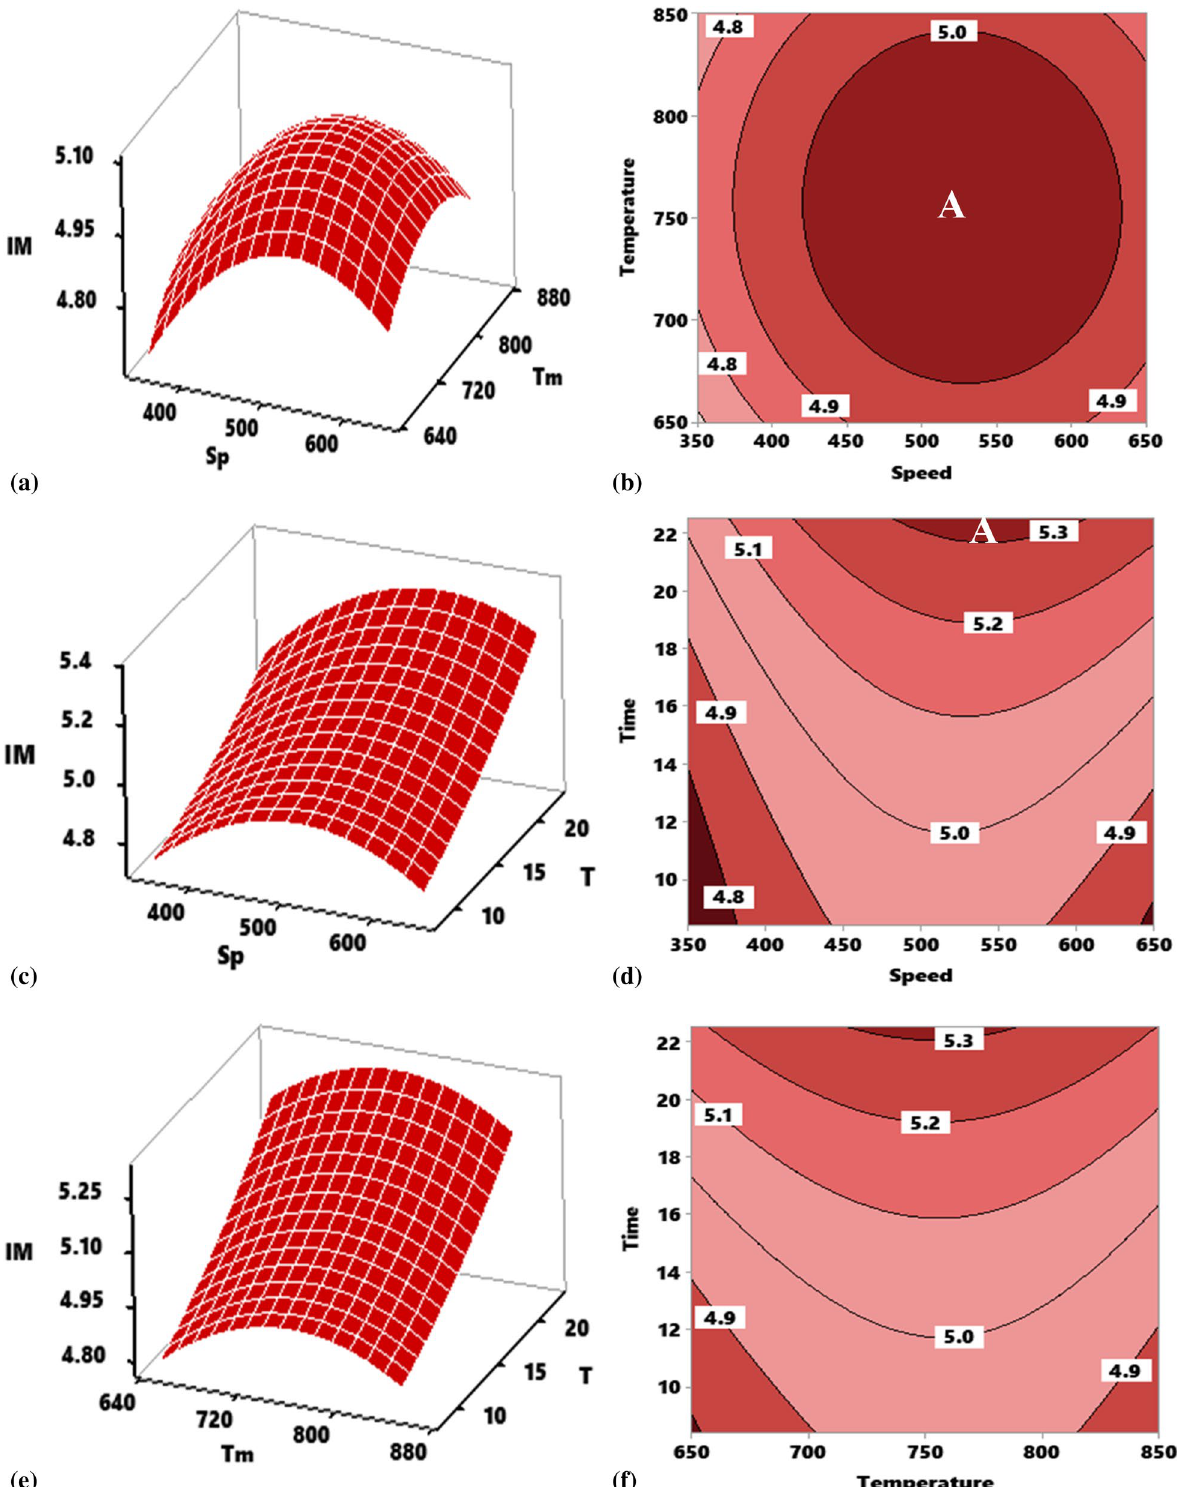
Figure 5. Influence of stirring parameter on impact strength of developed composite as represented by response surface plot and contour plot for interactions. ( a , b ) Speed and temperature, ( c , d ) speed and time, ( e , f ) temperature and